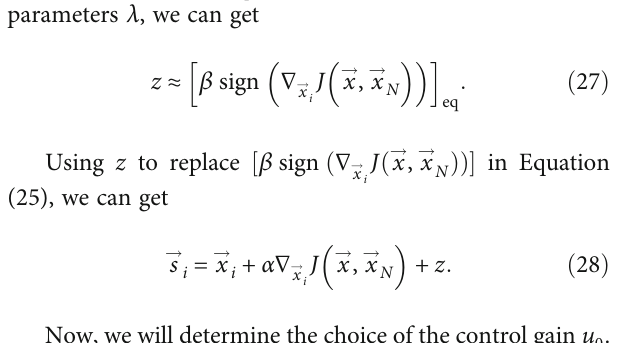
ponent and a high frequency component during sliding mode. The low pass fi lter can cut the high frequency compo-